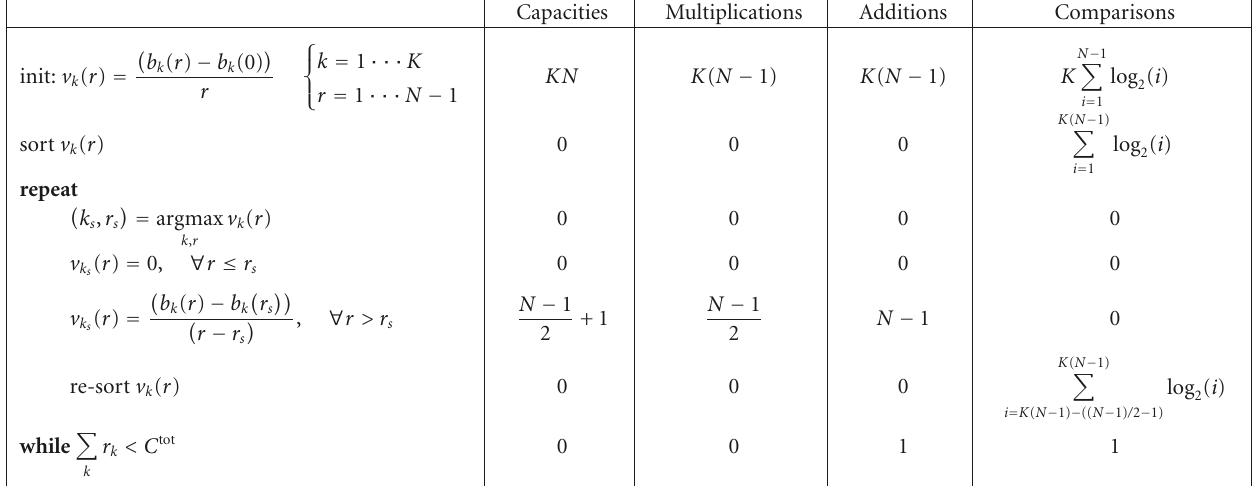
Algorithm 2: Single-user resource allocation